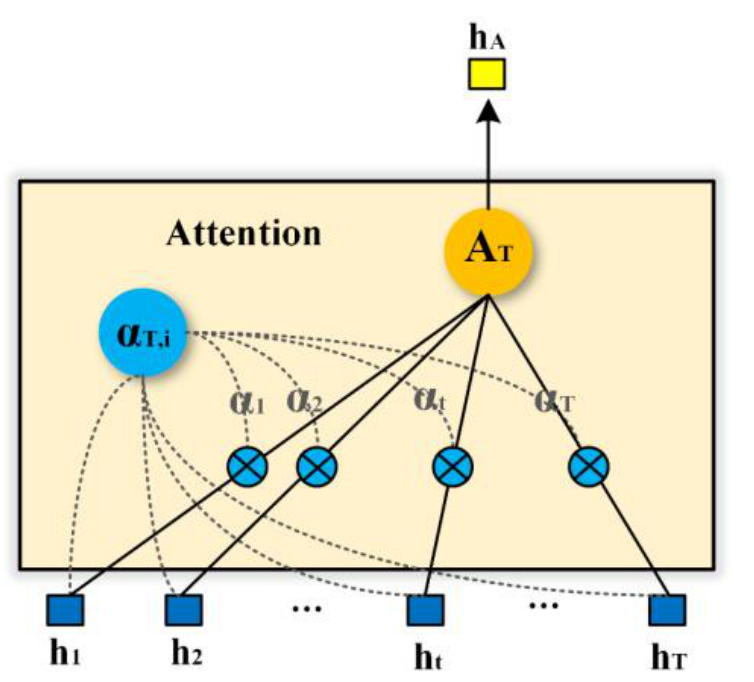
Figure 9. Network structure of the attention mechanism.